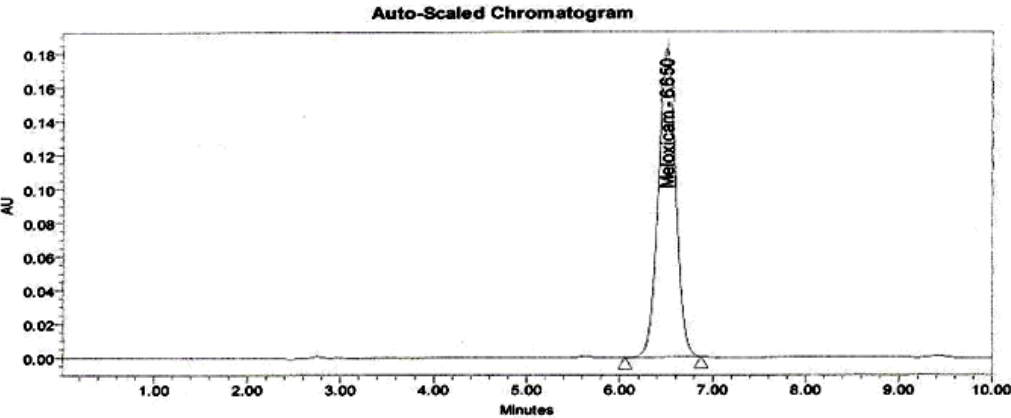
Figure-1. Plasma concentration of Meloxicam in HPLC data system after oral